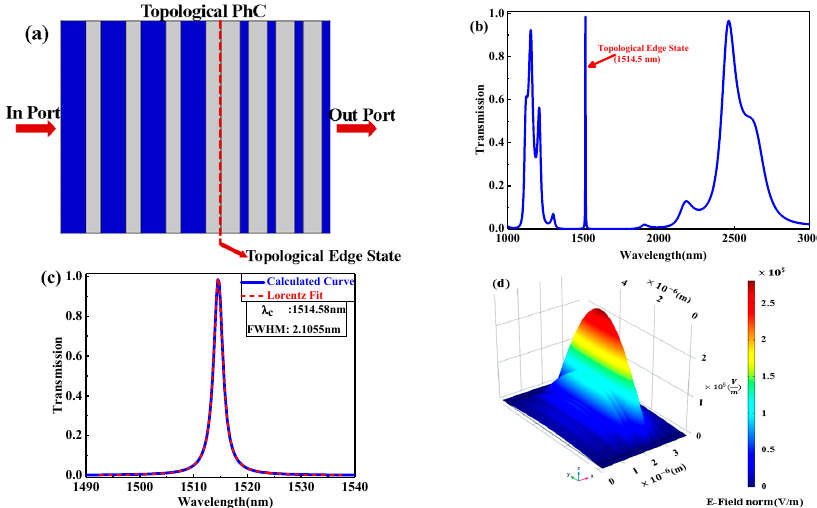
Figure 2. ( a ) Schematic diagram of the proposed 1D topological PhC; ( b ) the transmission spectrum of the topological PhC; ( c ) the zoom-in of the sharp peak of topological edge state and the dashed line shows the fitting curve, which is symmetric, in the typical Lorentzian-line shape; ( d ) the electric